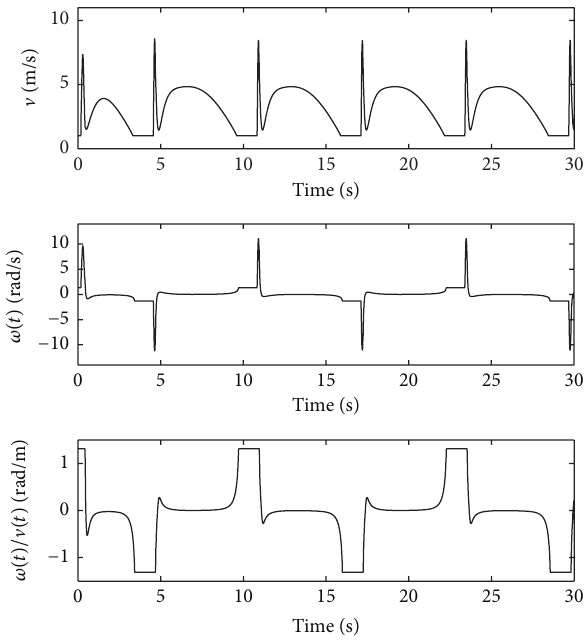
Figure 11: Controller commands for sinusoidal trajectory with